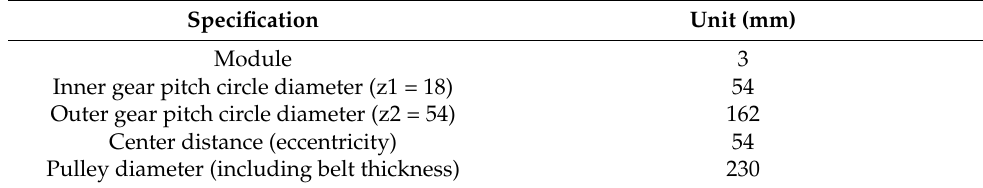
Table 3. Transmission